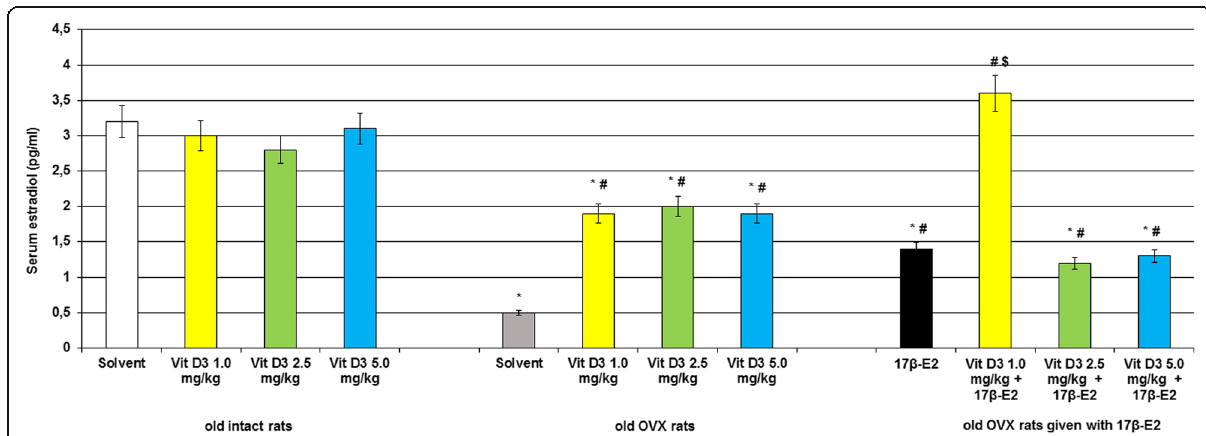
Fig. 3 Effects of Vitamin D 3 administration on estradiol level of the old ovariectomized (OVX) rats following long-term estrogen deficiency in the serum blood. The obtained results show the mean ± standard error of the mean (SEM). * – p < 0.05 as compared to the control group of the old sham-operated rats; # – p < 0.05 as compared to the old OVX rats treated with solvent; $ – p < 0.05 as compared to the old OVX rats treated with 17 β -estradiol (17 β -E 2 ). Each group comprised a minimum of eight rats. Cholecalciferol was given at 1.0, 2.5 or 5.0 mg/kg/daysubcutaneously (s.c.), once daily, for 14 days. The administered dose of 17 β -estradiol was 0.5 μ g/rat s.c., once daily, for 14